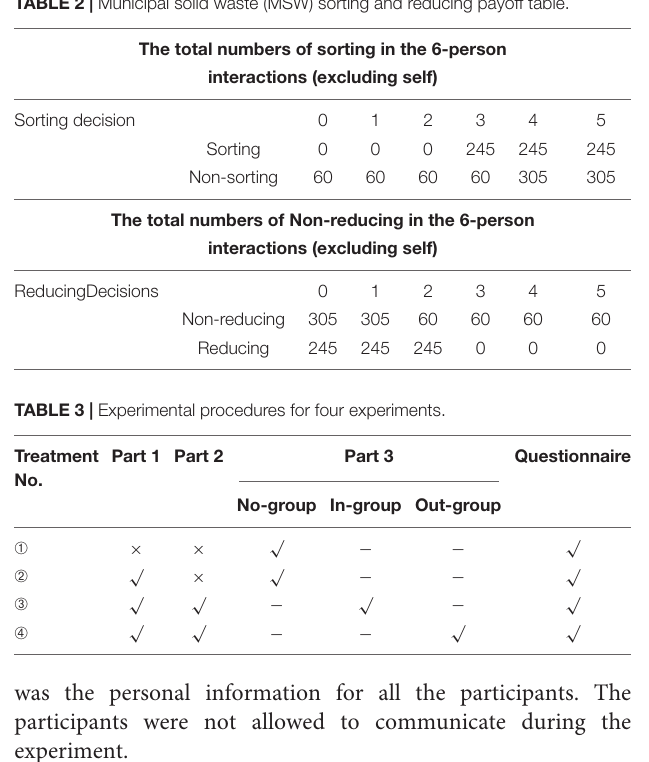
TABLE 2 | Municipal solid waste (MSW) sorting and reducing payoff table.